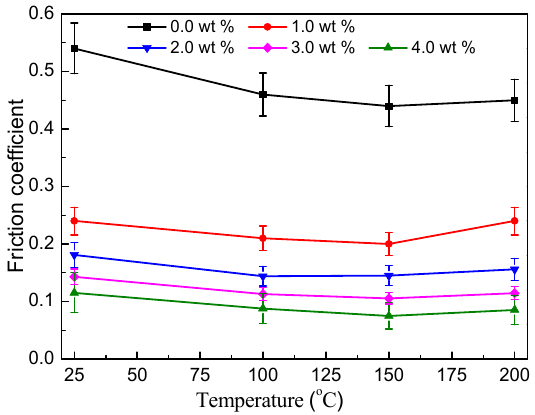
Figure 6. Influence of temperature on the friction coefficient of the polymer composite coatings.